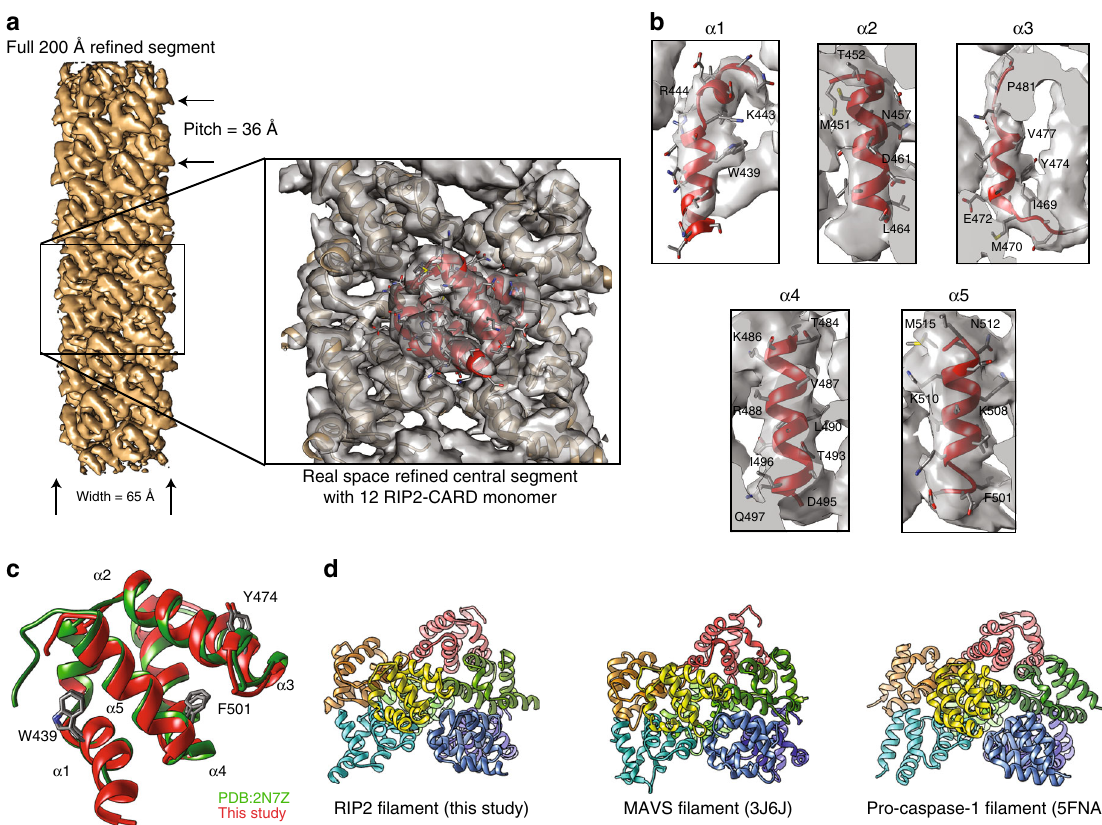
Fig. 5 A RIP2 – CARD 12mer structure based on cryo-EM density. a Cartoon illustration of the average segment density of activated RIP2 – CARD fi lamentous structure (EMDB code: 6482). The image was prepared using Chimera with auto-adjusted contour level. Twelve monomers of RIP2 – CARD were fi tted into the central segment according to the protocol. b Close view of the electron density. Five different α -helices from RIP2 – CARD fi tted nicely into the density map, with the aromatic side chains at important references for determining the registry. c Comparison of RIP2 – CARD monomer models from PDB (green) and this study (red). d Different fi lamentous structures composed of CARD-containing proteins including RIP2, MAVS, and pro-caspase-1. It was